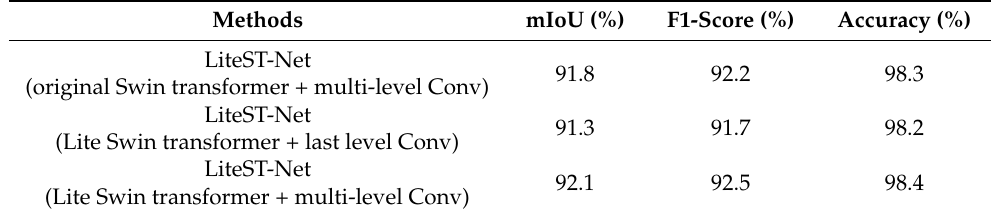
Table 4. Results of LiteST-Net on the WHU building test